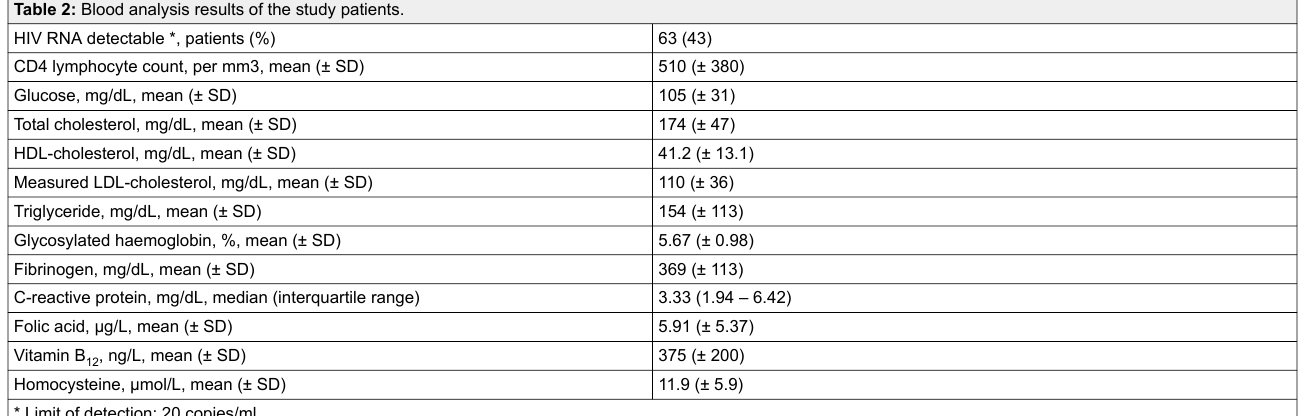
Table 2: Blood analysis results of the study patients. HIV RNA detectable *, patients